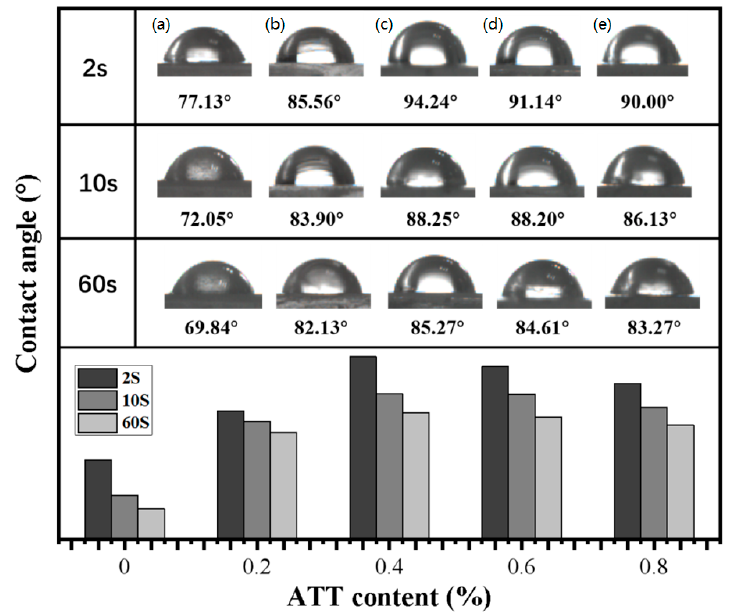
Figure 13. Contact angle data: ( a ) MPP; ( b ) MPP 99.8 ATT 0.2 ; ( c ) MPP 99.6 ATT 0.4 ; ( d ) MPP 99.4 ATT 0.6 ; ( e ) MPP 99.2 ATT 0.8